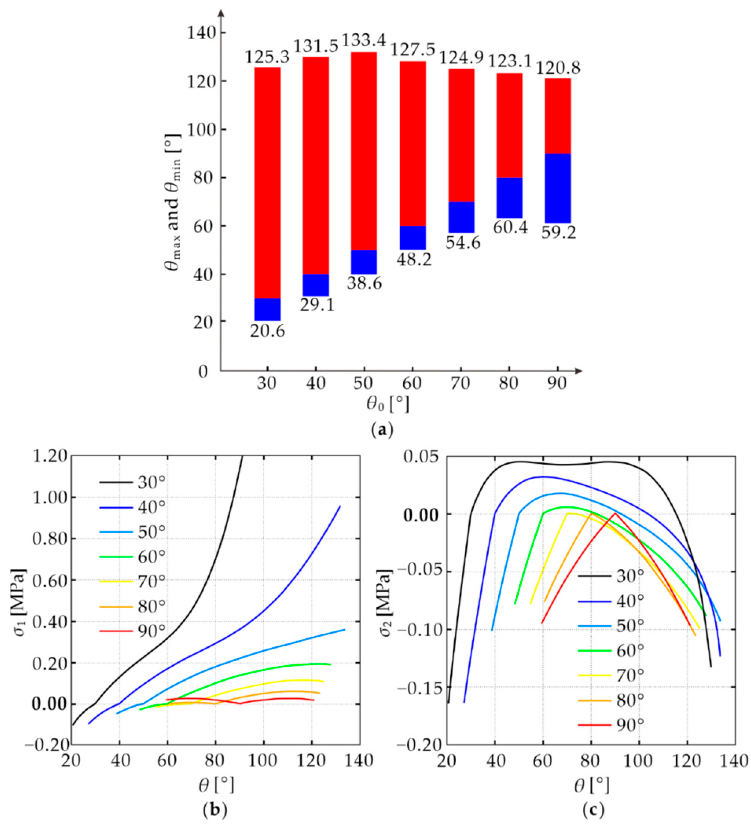
Figure 9. ( a ) Maximal and minimal critical wrinkling angles; ( b ) maximal principal stress versus morphing angle curves; ( c ) minimal principal stress versus morphing angle curves.